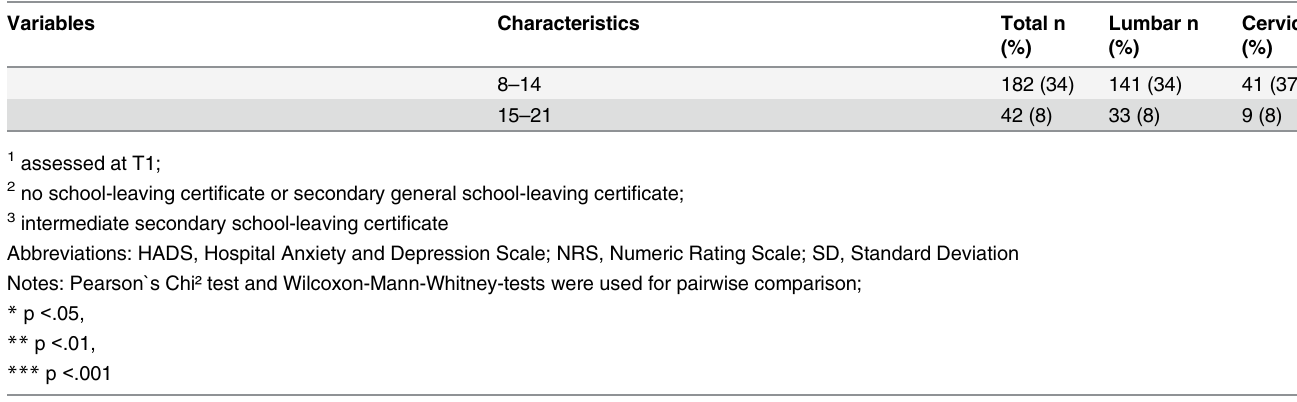
Table 2 shows the results of the multilevel mixed-effects negative binomial regression model for the group of patients treated for lumbar herniated disc. Within this model average pain decreased significantly over time (Chi² = 25.97, p < 0.001). The comparison of baseline pain with T1 did not reach statistical significance, but pain ratings at T2, T3 and T4 were signifi- cantly lower compared to baseline showing a constant decrease. Moreover, pain intensity var- ied significantly between subjects at T0 (Random Intercept = 0.18, p < 0.01) and the courses of pain over time were interindividually different (Random Slope = 0.04, p < 0.01). Based on this model the marginal means of pain intensity were calculated for each assessment, holding all other covariates at their means (left side of Fig 2). The estimated marginal pain